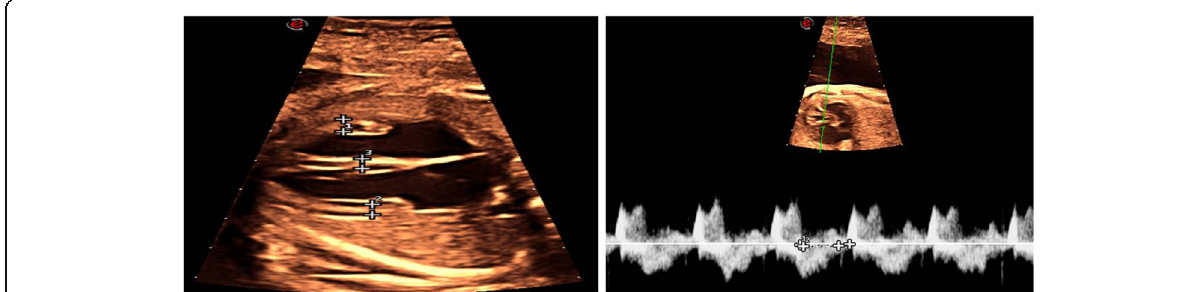
Fig. 5 2D measurement of myocardial and septal wall thickness in lateral 4 chamber view and Doppler derived measurement of left modified myocardial performance index in a pregnant female 22 years with no history of maternal diabetes. Both tie index and myocardial and septal wall